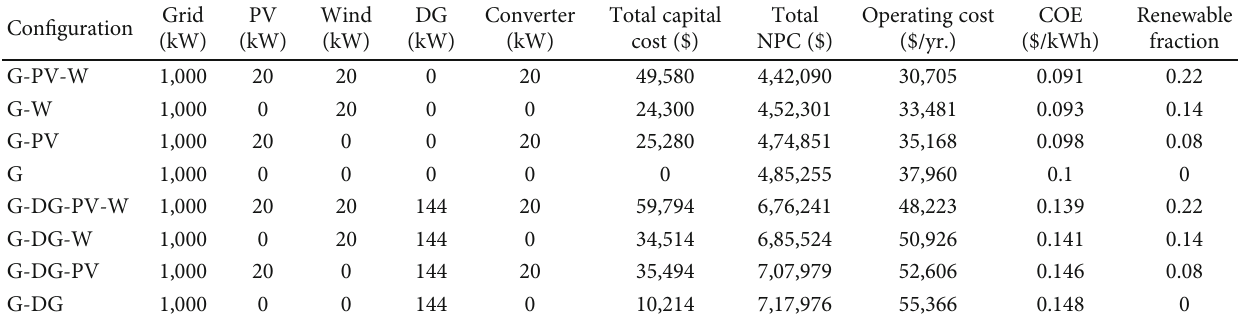
Table 3: HOMER optimization result for di ff erent criteria.